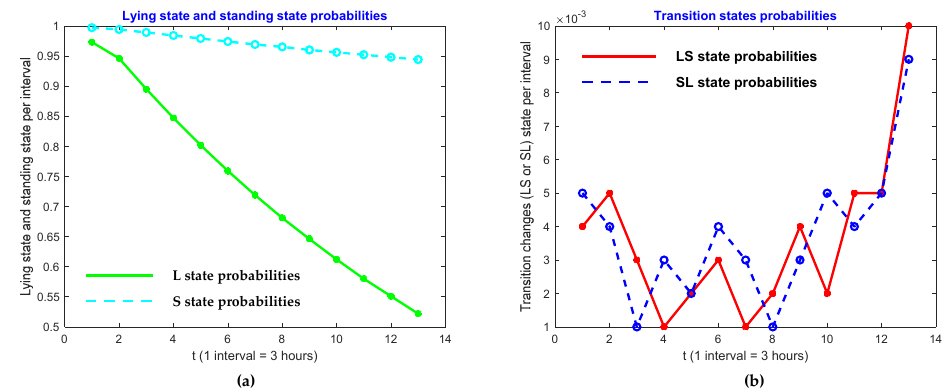
Figure 6. Comparison of ( a ) lying state and ( b ) transition state probabilities of ID 11.